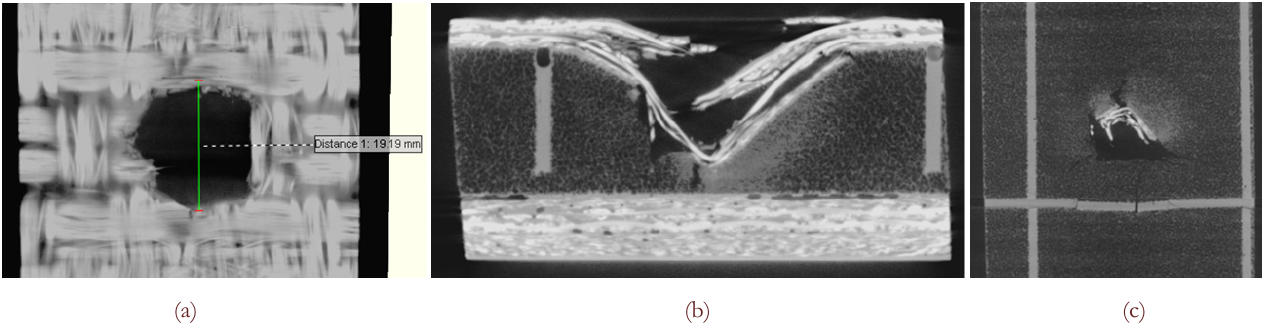
Figure 13: Tomographic images of the damaged GFRP-PVC foam core panel after the impact (v = 6